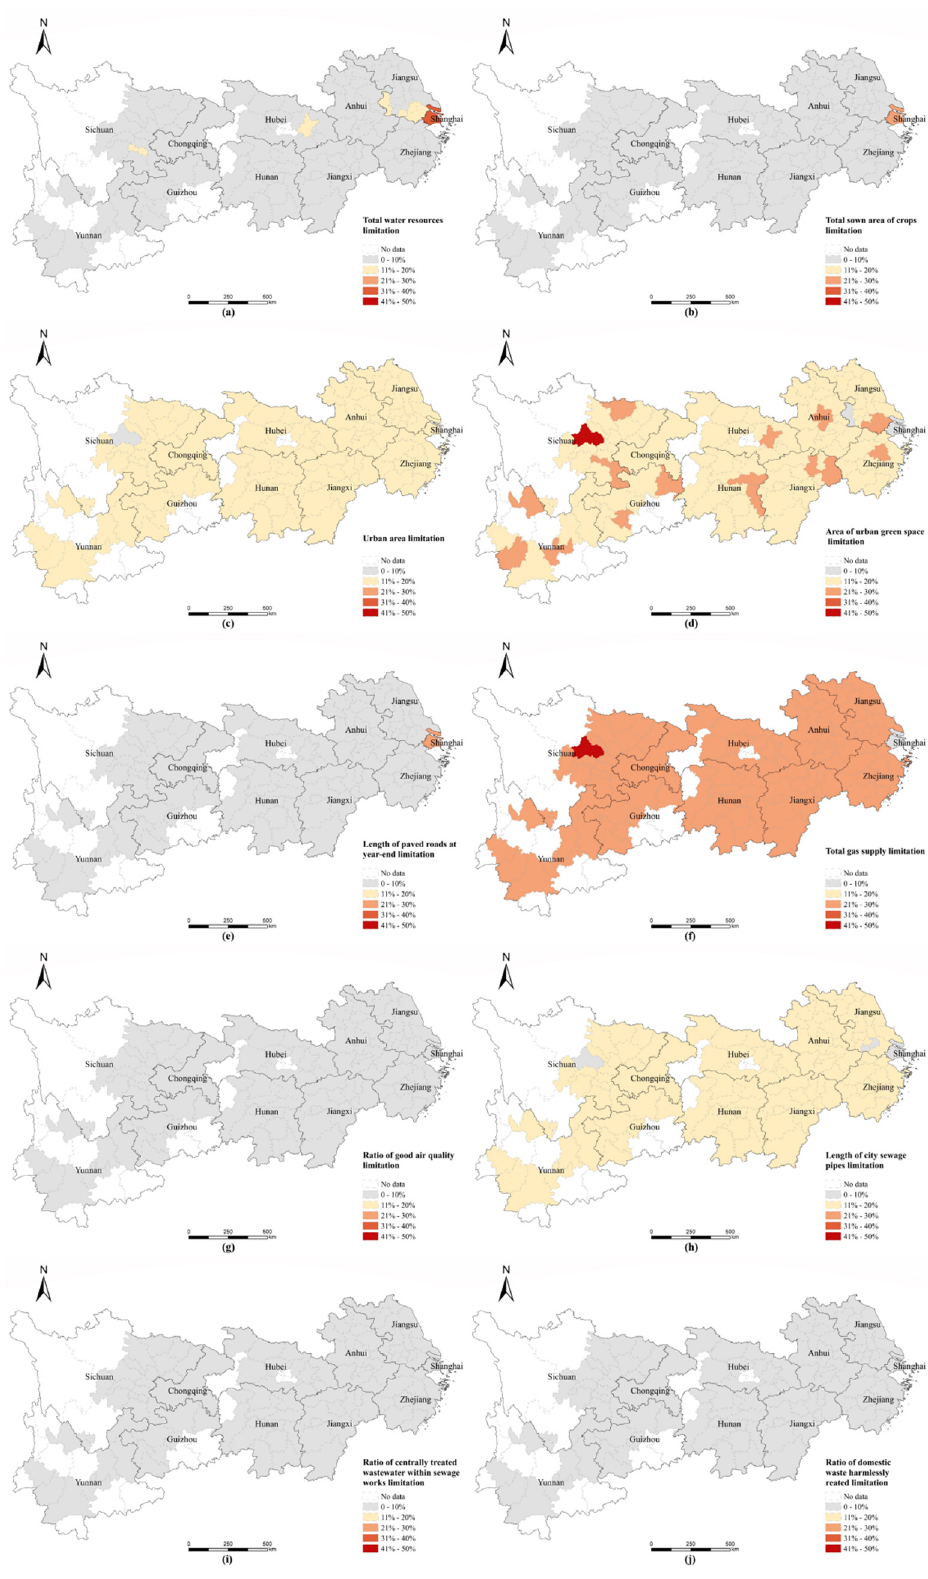
Figure 8. Obstacle factors and spatial distribution of RES index of cities in the Yangtze River Economic Belt.